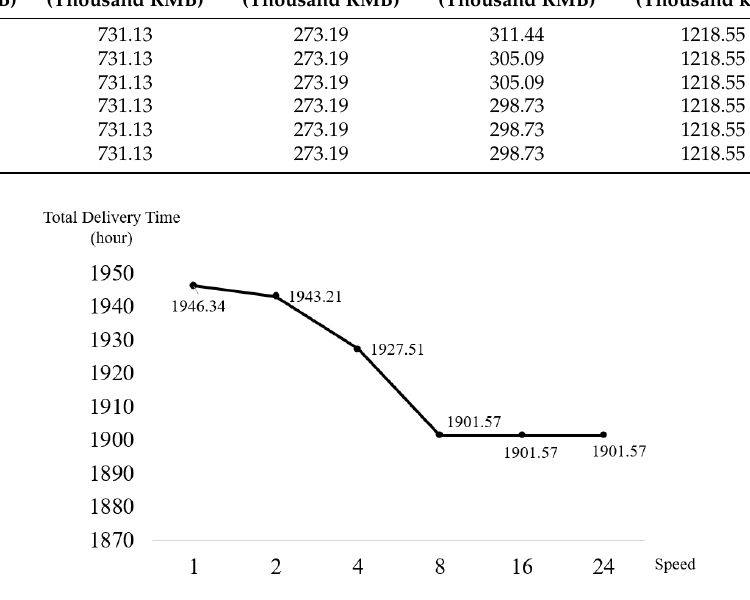
Figure 5. Total delivery time (hours) under different charging speed.